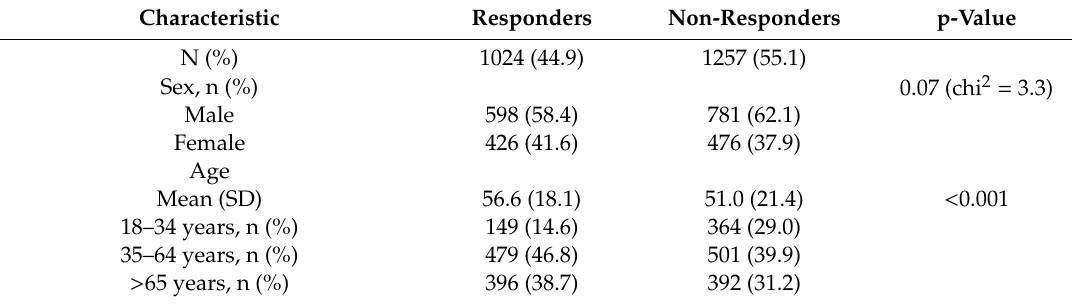
Table A2. Characteristics of responders and